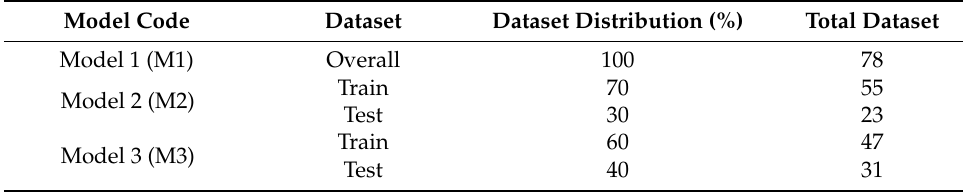
Table 4. The dataset distribution for the ANN and MLR models.